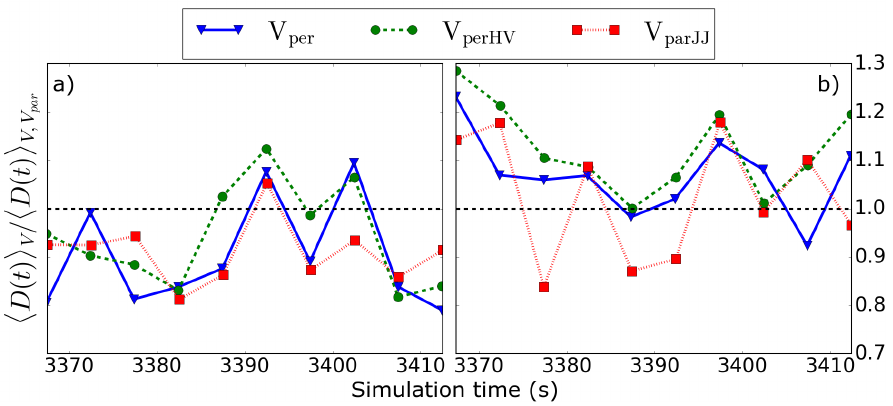
Figure 12. The volume averaged particle dilution rate (cid:104) D ( t ) (cid:105) V (m − 3 s − 1 ) between z = 1–20 m under the ( a ) general and ( b ) wintry inflow conditions. Results are represented relative to V par ( (cid:104) D ( t ) (cid:105) V ,V